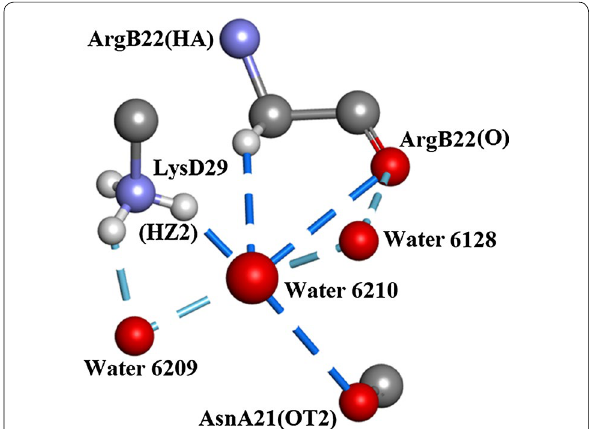
Fig. 8 Water 6210 hydrogen bonds to two waters and three amino acid side‑chains. Drawn with Biovia, Discovery Studio 2016 [35]